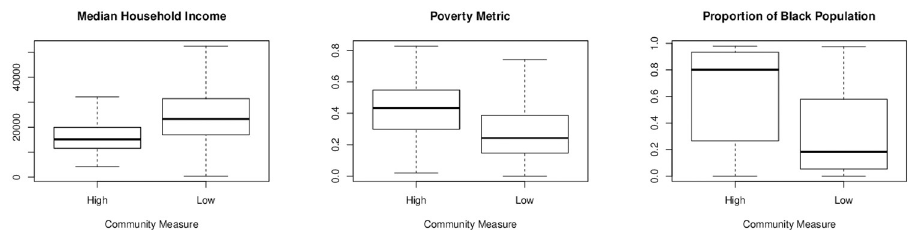
Fig 2. Distribution of median household income, poverty metric, and proportion of black population between high and low vibrancy neighborhoods in Philadelphia.